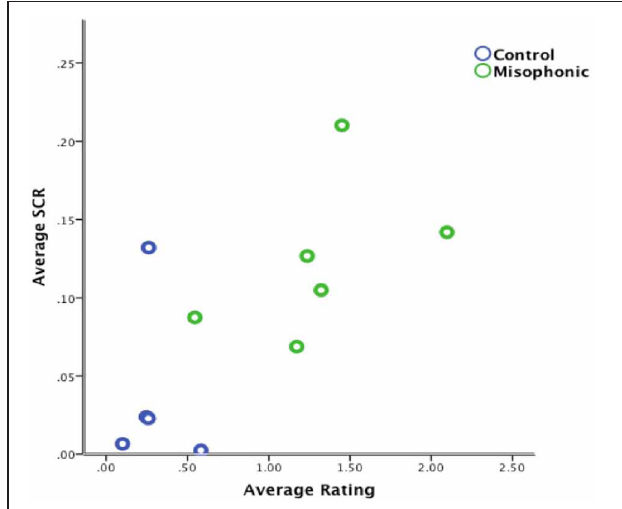
FIGURE 4 | Correlation of average aversiveness ratings and average SCR (in micro Siemens) for all trials across all subjects.